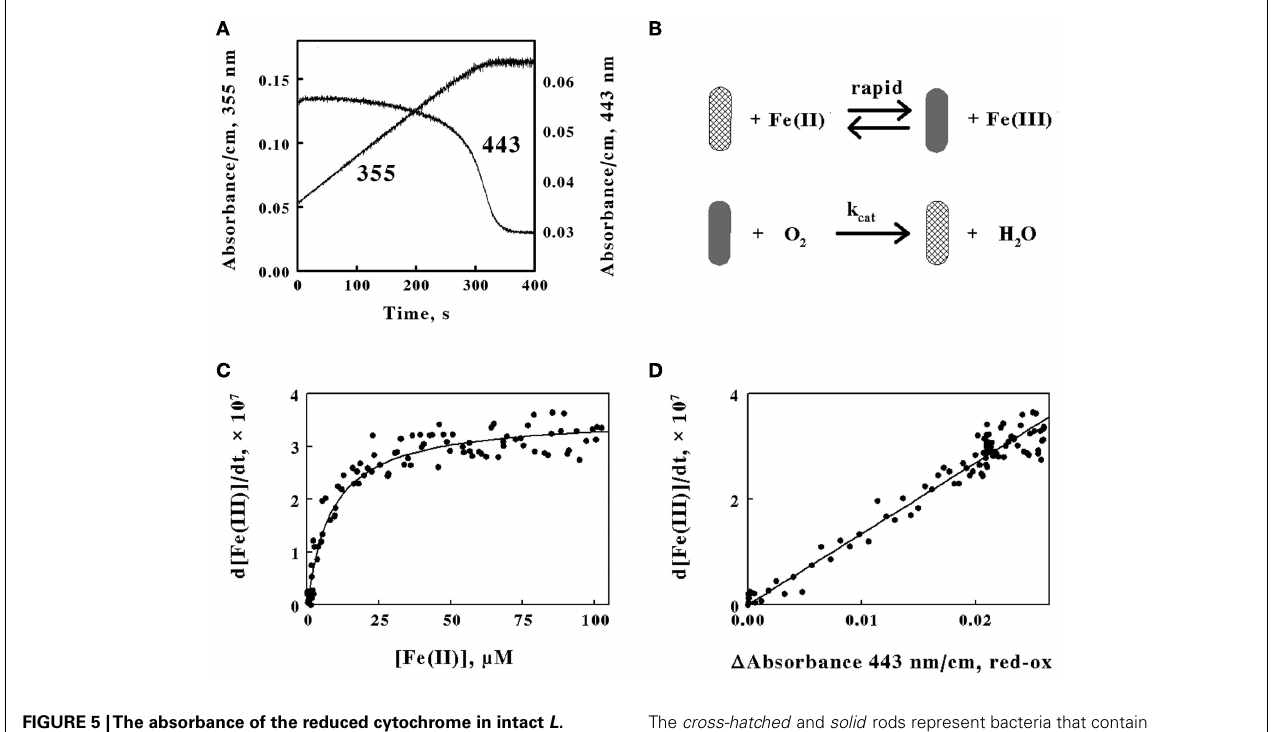
FIGURE 5 |The absorbance of the reduced cytochrome in intact L. ferrooxidans correlates with the absorbance of ferric ions produced during aerobic respiration on soluble iron. (A) Time courses of the absorbance changes at 355 and 443nm obtained when 2.1 × 10 9 cells of L. ferrooxidans were mixed with 100 μ M ferrous sulfate in sulfuric acid, pH 1.7. (B) Schematic representation of the kinetic mechanism for aerobic respiration on soluble iron as catalyzed by intact L. ferrooxidans .